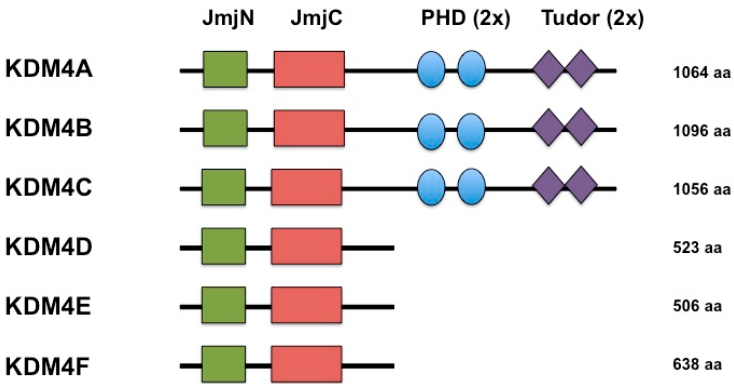
Figure 1. Diagram of the comparative domain structures of the KDM4 histone demethylases (adapted from Katoh and Katoh, 2004).